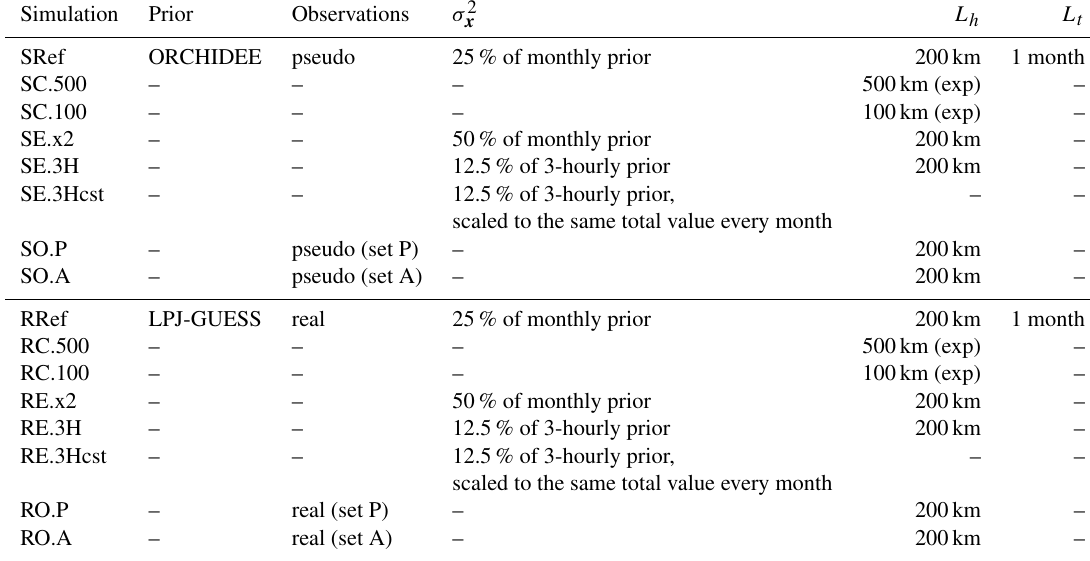
Table 3. List of inversion experiments performed. The restricted observation sets A and P are reported in Table 1. Simulation Prior Observations σ 2 x L h L t SRef ORCHIDEE pseudo 25% of monthly prior 200km SC.500 SC.100